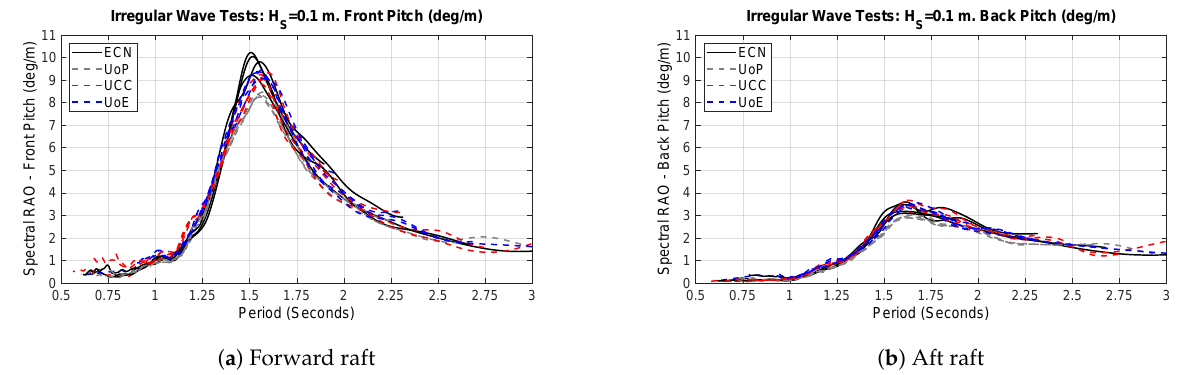
Figure 10. Pitch RAO for H s of 0.1 m across facilities.